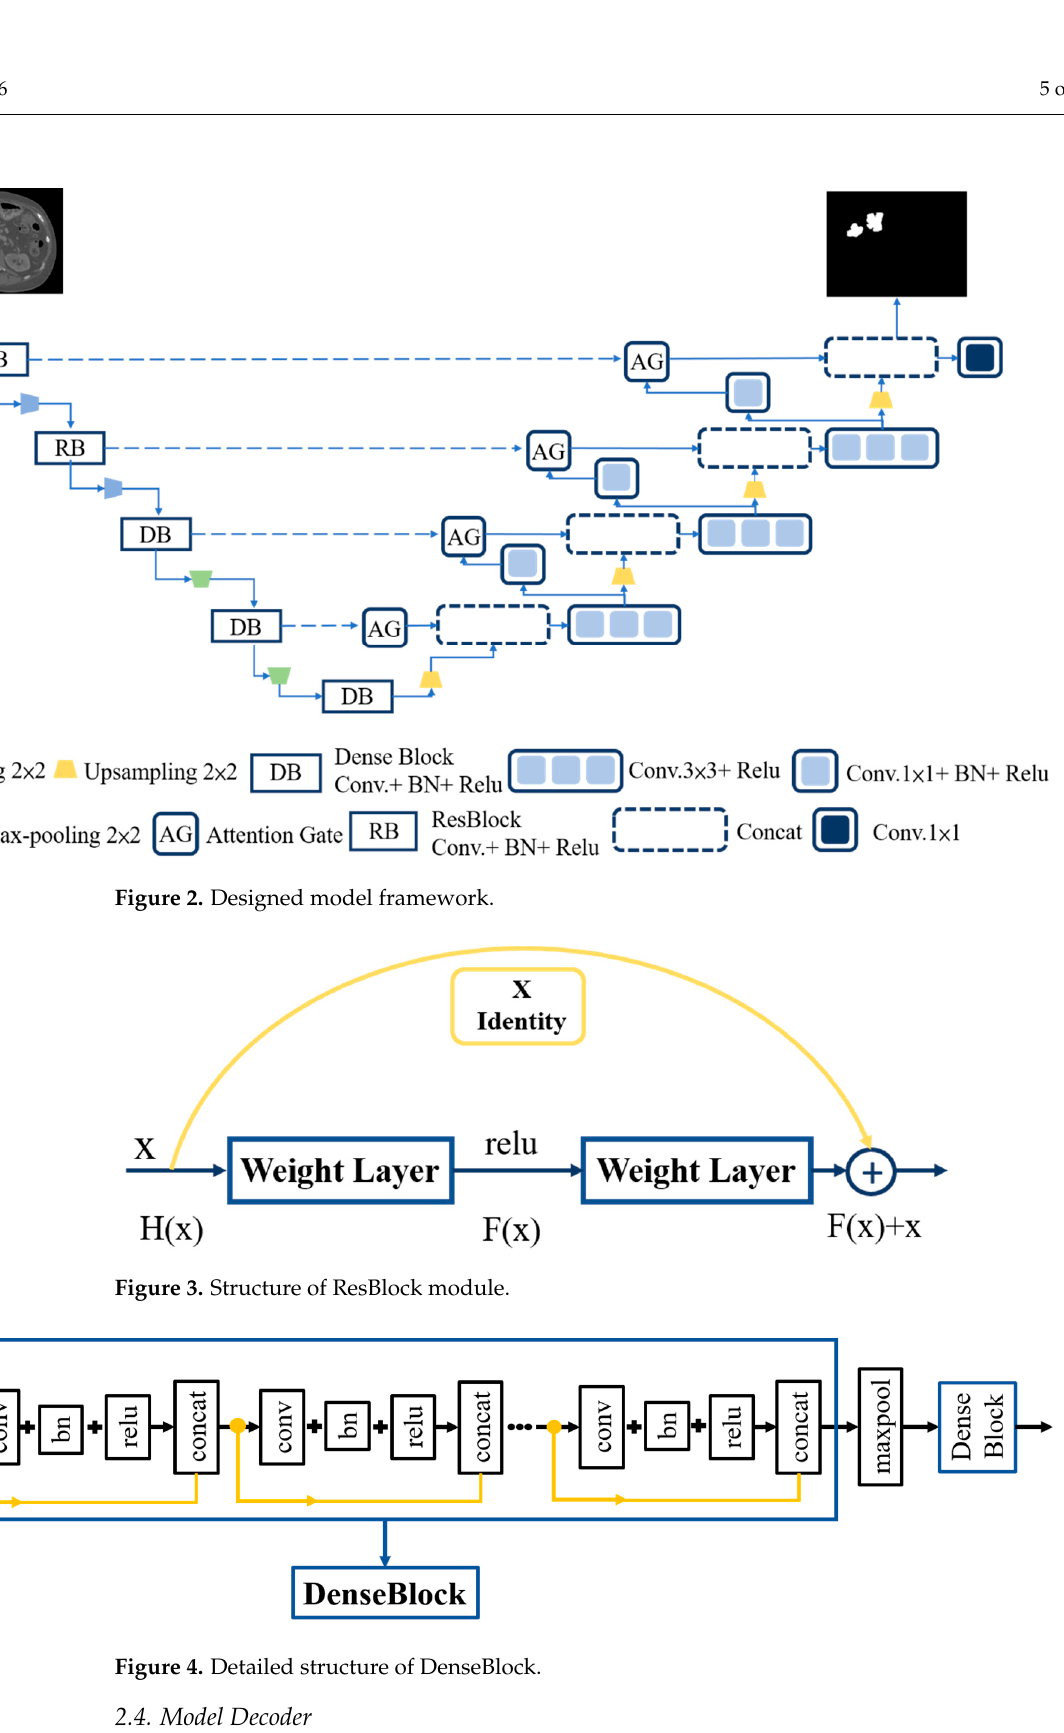
Figure 3. Structure of ResBlock module.